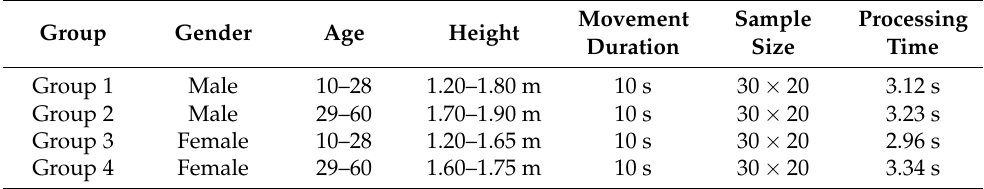
Table 1. Experimental parameter setting.